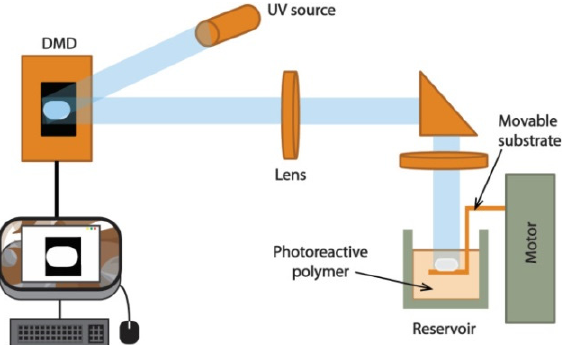
Figure 17. DLP equipment scheme [71]. Reprinted with permission from